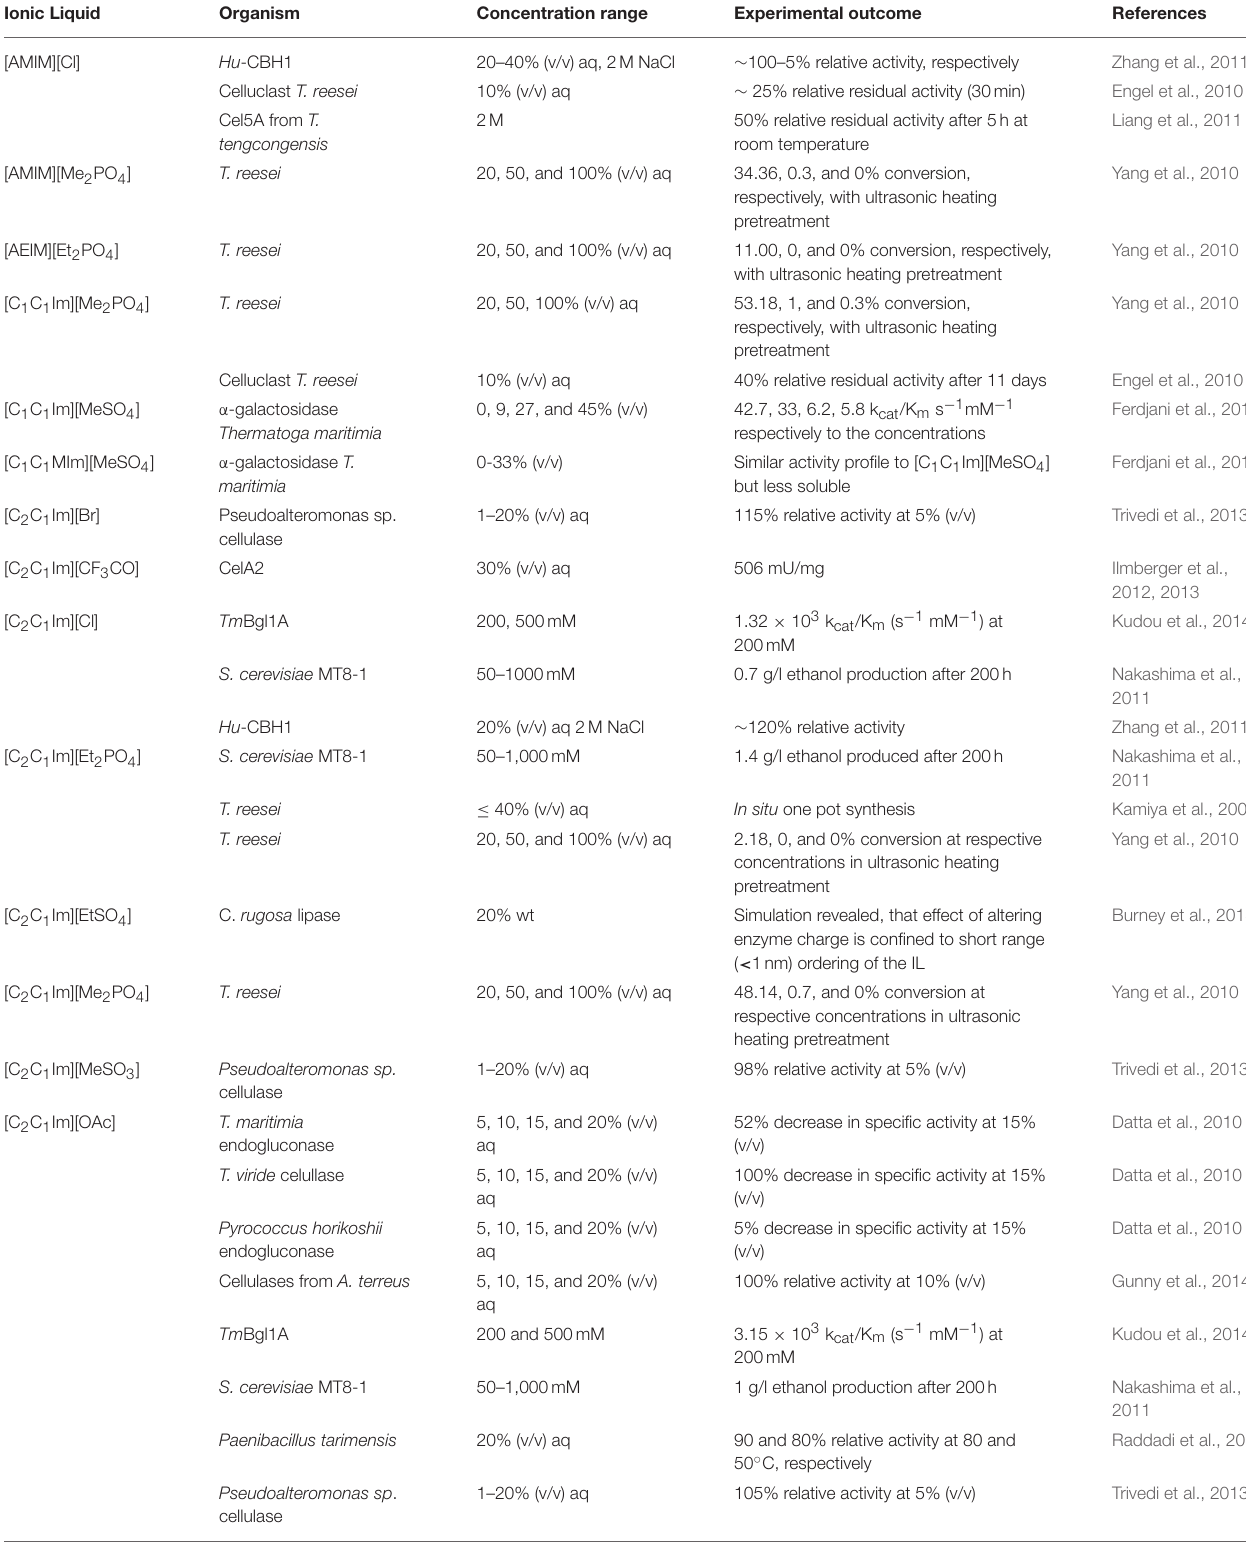
TABLE 4 | Summary of selected cellulase reactions in ionic liquids. Ionic